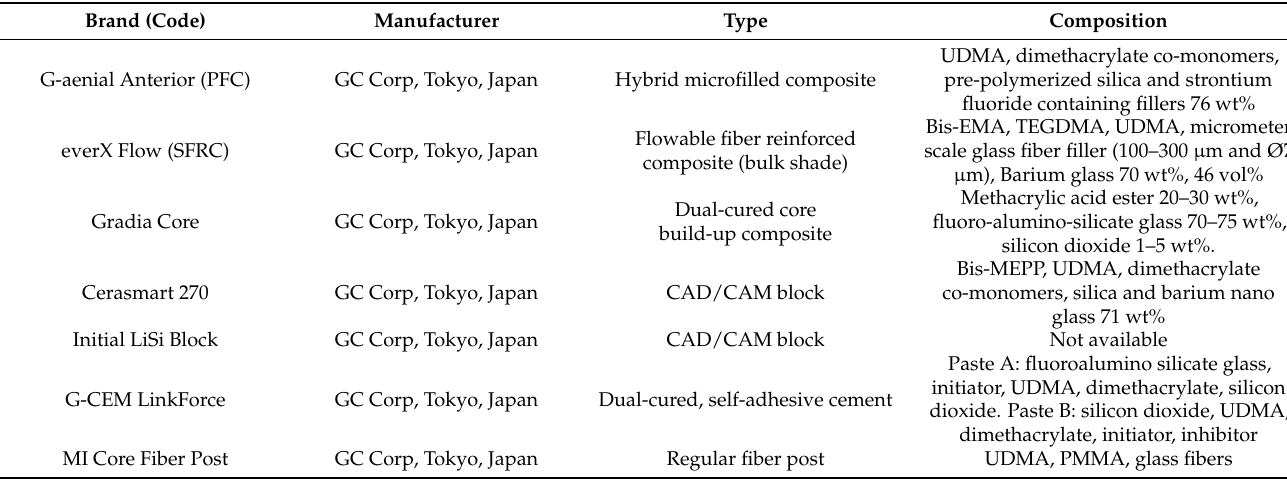
Table 1. The used materials.